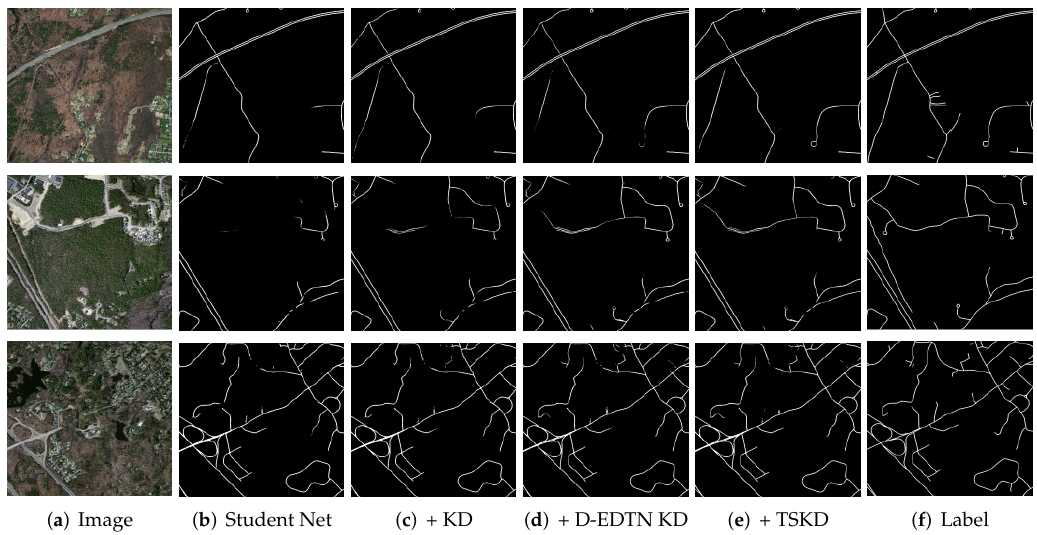
Figure 10. Performance comparison of student networks based on knowledge distillation with the Massachusetts Dataset. ( a ) Image; ( b ) results of the student net; ( c ) results of the student net with knowledge distillation (KD); ( d ) results of the student net with D-EDTN KD; ( e ) results of the student net with TSKD; ( f ) label.